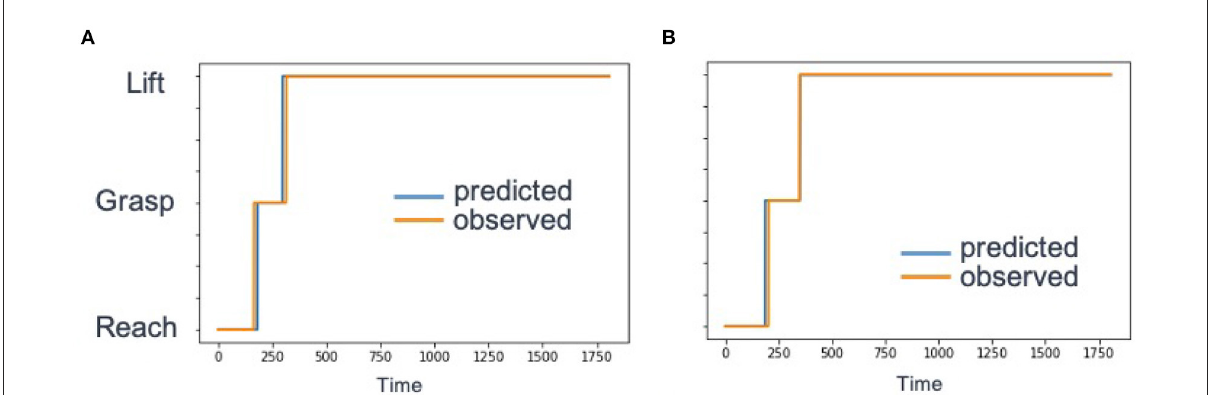
FIGURE5 Example behavior primitive label accuracy for a single test demonstration. We compared the label predictions given by PICO (red) to the ground truth (blue). (A) A sample reconstruction for a single trajectory with an existing behavior primitive library. Timepoints are on the x-axis. and behavior primitive label is on they y-axis. The labels 0, 1, and 2 correspond to reach, grasp, and lift, respectively. (B) Reconstruction of an example trajectory and discovery of a missing behavior primitive (grasp).